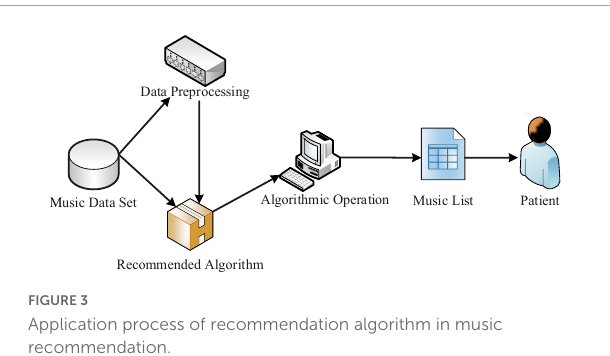
FIGURE3 Application process of recommendation algorithm in music